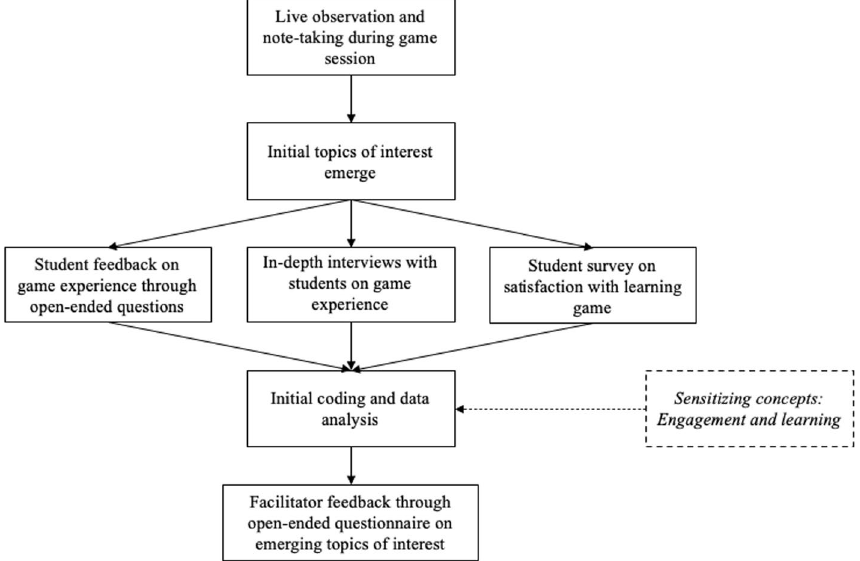
Fig. 2 Data sources and their order of